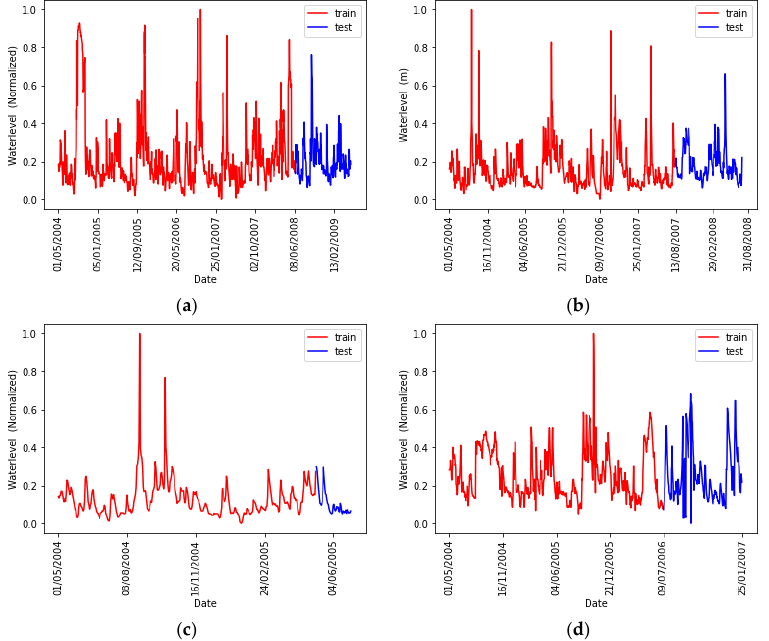
Figure 4. Train – Test data split of ( a ) Kimbulawala, ( b ) Kotte Canal, ( c ) Kotte North, and ( d ) Parliament Lake .